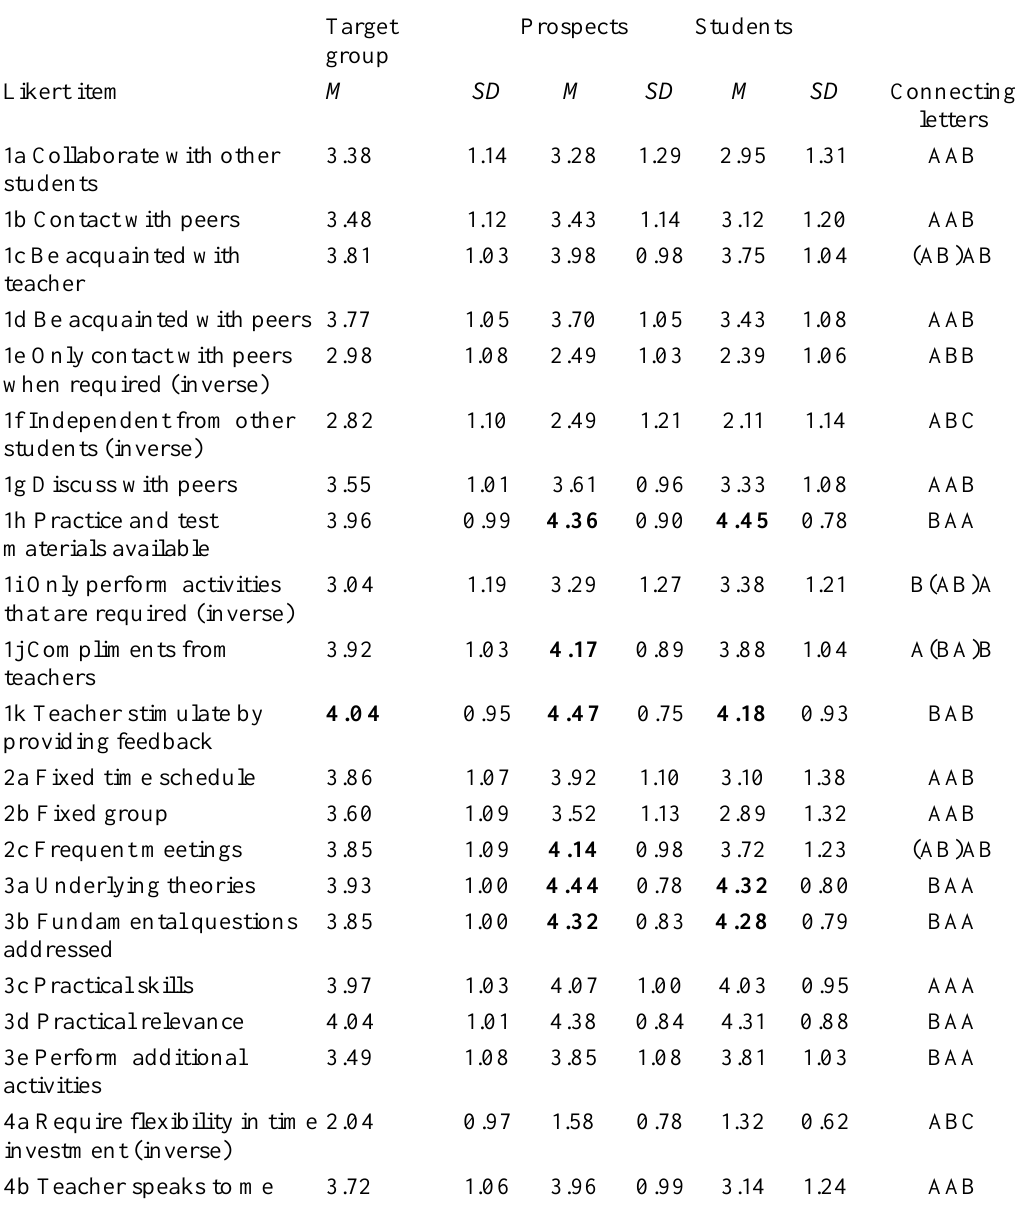
Means and Standard Deviations for Each Likert Item, with Comparison Between Means (T-Test For all Pairs, Using Tukey-Kramer HSD). Items That Are Reversed Have The Tag